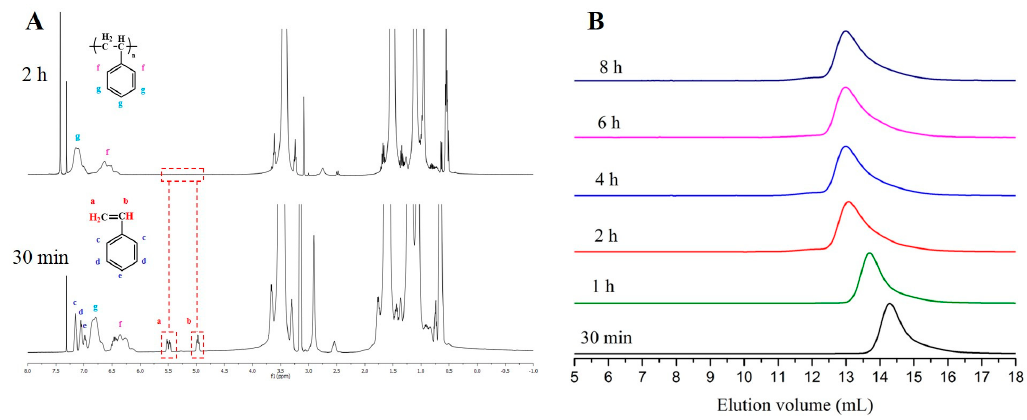
Figure 2. ( A ) 1 H-NMR spectra after 30 min. and 2 h (100% conversion) {[ t -BuP 2 ]/[ sec -BuLi]:1/1, styrene}; ( B ) SEC traces obtained from withdrawn aliquots at different time intervals during the [ t